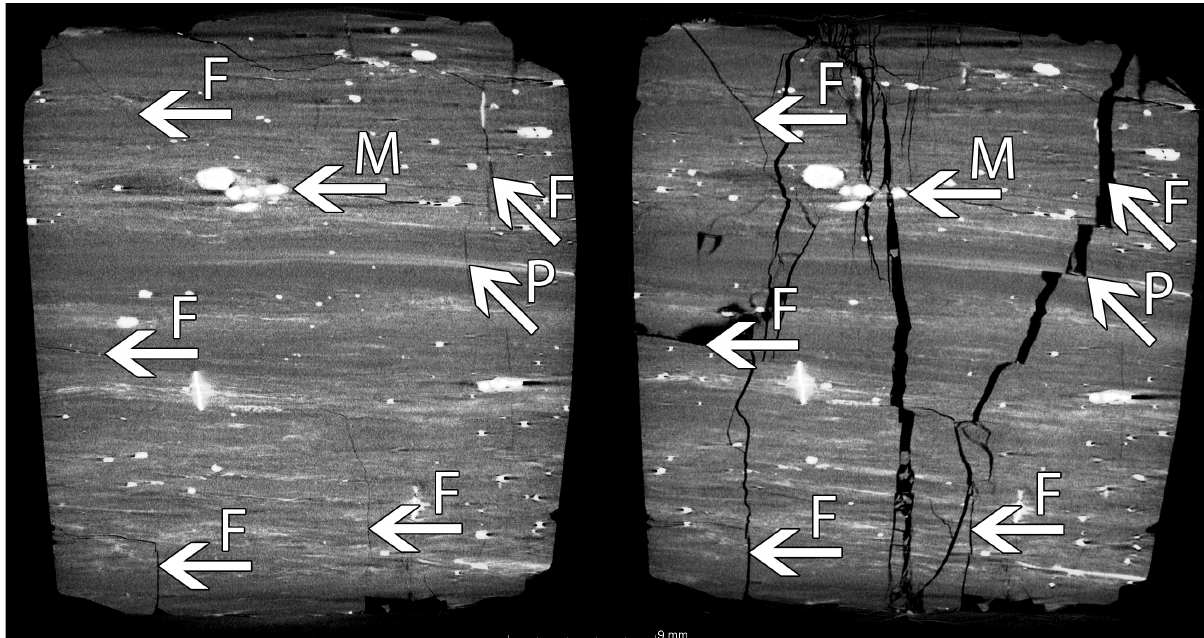
F indicates cleats or cracks that existed in the pre-loaded particles that enlarged during compression; M indicates mineral inclusions that may have had an influence on either crack initiation or crack propagation; P indicates either maceral–maceral boundaries or maceral–mineral boundaries that may have had an influence on crack initiation. Figure 2: Comparison of the before (left) and after (right) tomogram of a particle compressed perpendicular to the bedding plane in the Monsanto